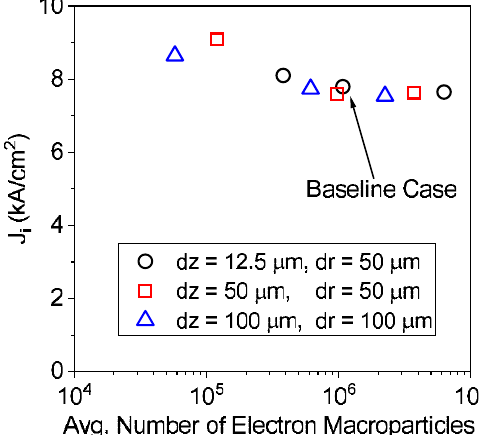
FIG. 9. Temporally and spatially averaged ion loss current density as a function of injected electron macroparticle number for different spatial resolutions. All results are for the baseline simulation case described in Sec.